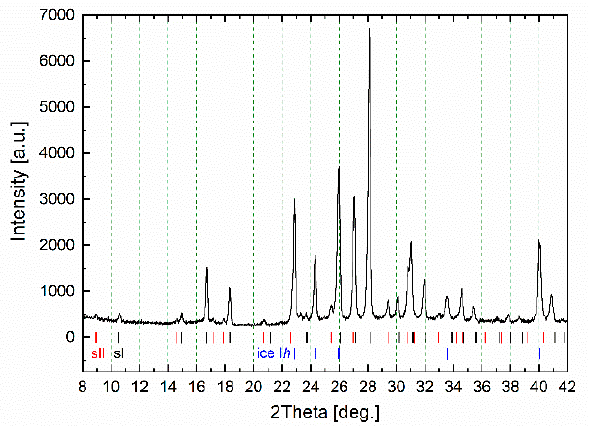
Figure 2. Powder X-Ray diffraction pattern of the studied gas hydrate measured at 173 K; sI, sII and ice I h correspond to the positions of reflections of the cubic structure I, cubic structure II hydrates and hexagonal ice.